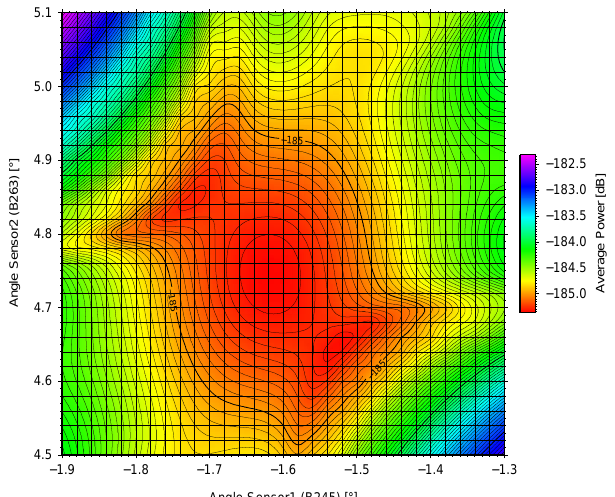
Fig. 4. Results from above experiment for the E/W-component. The increment used during the grid-search to find optimal alignment was 1% = 0 . 02 ◦